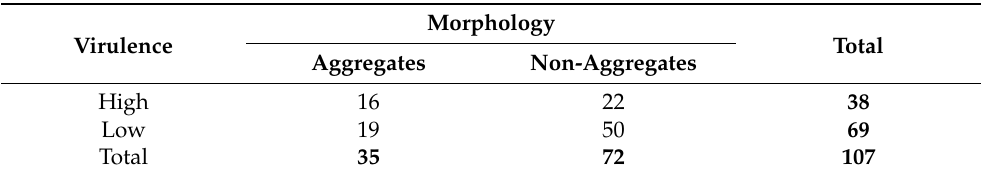
Figure 2. Virulence of aggregate-forming and non-aggregate strains of C. auris compared to C. albicans SC5314 in G. mellonella larvae at 37 °C. Kaplan–Meier plots of G. mellonella survival after injection with 10 6 cells/larva of Candida albicans (red line), non-aggregating C. auris strains (blue and black line), and aggregate-forming C. auris strains (pink and green line) are shown. Experiments were performed in triplicate with 10 larvae per strain in each experiment. No larval killing was observed in control larvae injected with an equivalent volume of PBS (black arrowed lines). Table 3. Strains of C. auris with high and low virulence tested with the type of cell morphology, the difference was not statistically significant ( p = 0.124).